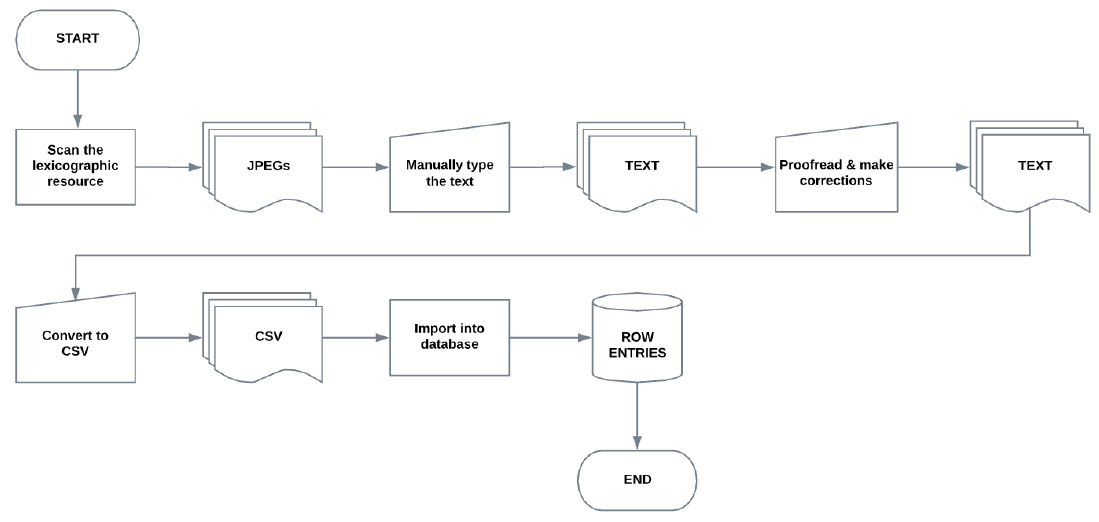
Figure 3. Workflow illustrating the digitisation process.